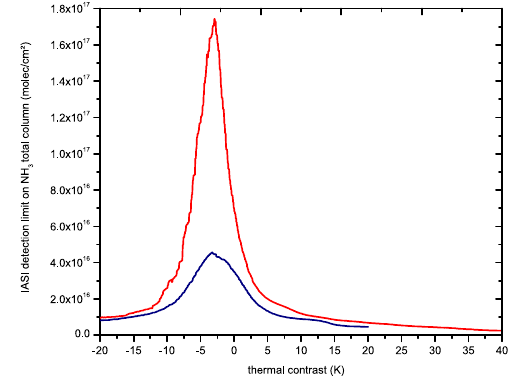
Fig. 5. Lowest possible detectable NH 3 total column, in moleccm − 2 , above land (red) and sea (blue). The values are those for which the retrieved column would be significant below 2 σ in